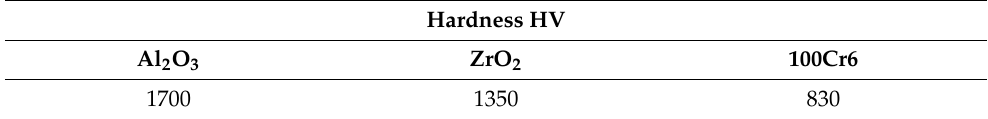
Table 2. The hardness of the balls used in the tribological tests.